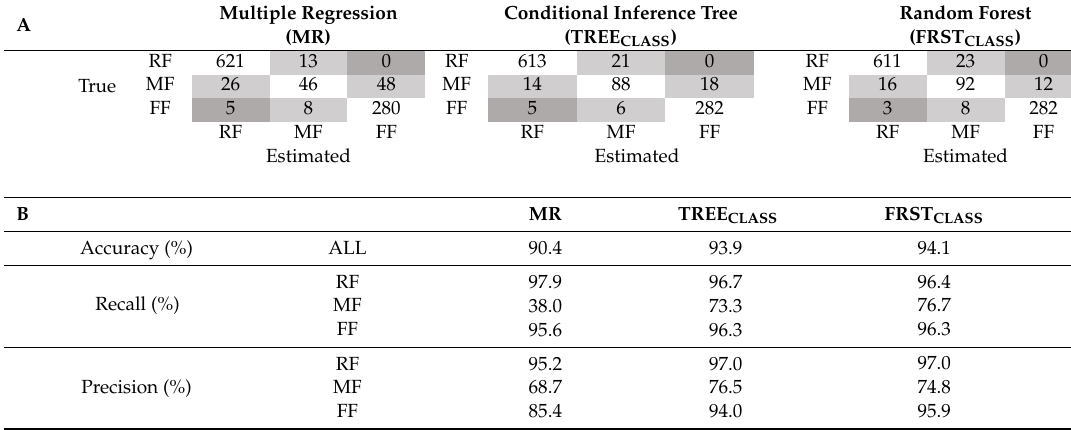
Table 4. Confusion matrices are displayed to indicate where correct (white) and incorrect (grey) classifications occurred for three types of classification methods (multiple linear regression, conditional inference tree, and random forest). Matrices are reported for the validation data set that was not included in model training. All models classified foot strikes into three classes: RF = rear foot, MF = mid foot, and FF = fore